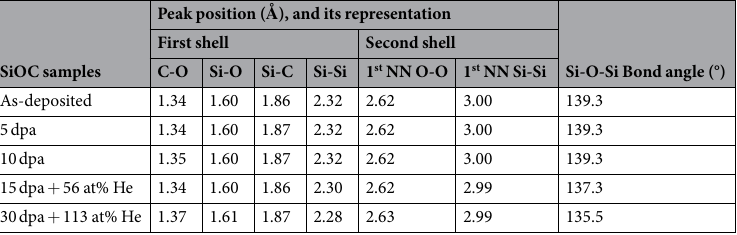
Si-O-Si Bond angle